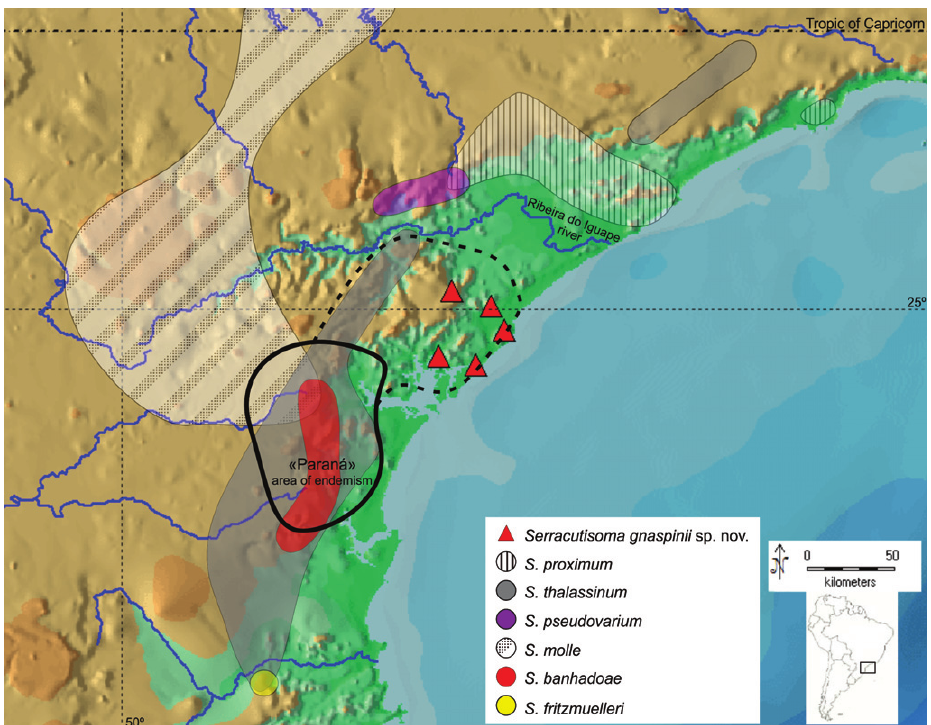
Figure 7. Records of the new species and the distributions of other species of S. proximum group in southern São Paulo, Paraná and north Santa Catarina states coasts. Ribeira do Iguape river flows between the sister-species S. proximum and S. gnaspinii sp. nov. Black solid line: limits of Congruence core of “Paraná” area of endemism; dashed line: limits of Maximum Region of Endemism of “Paraná” area of endemism (see D A S ILVA & P INTO - DA -R OCHA